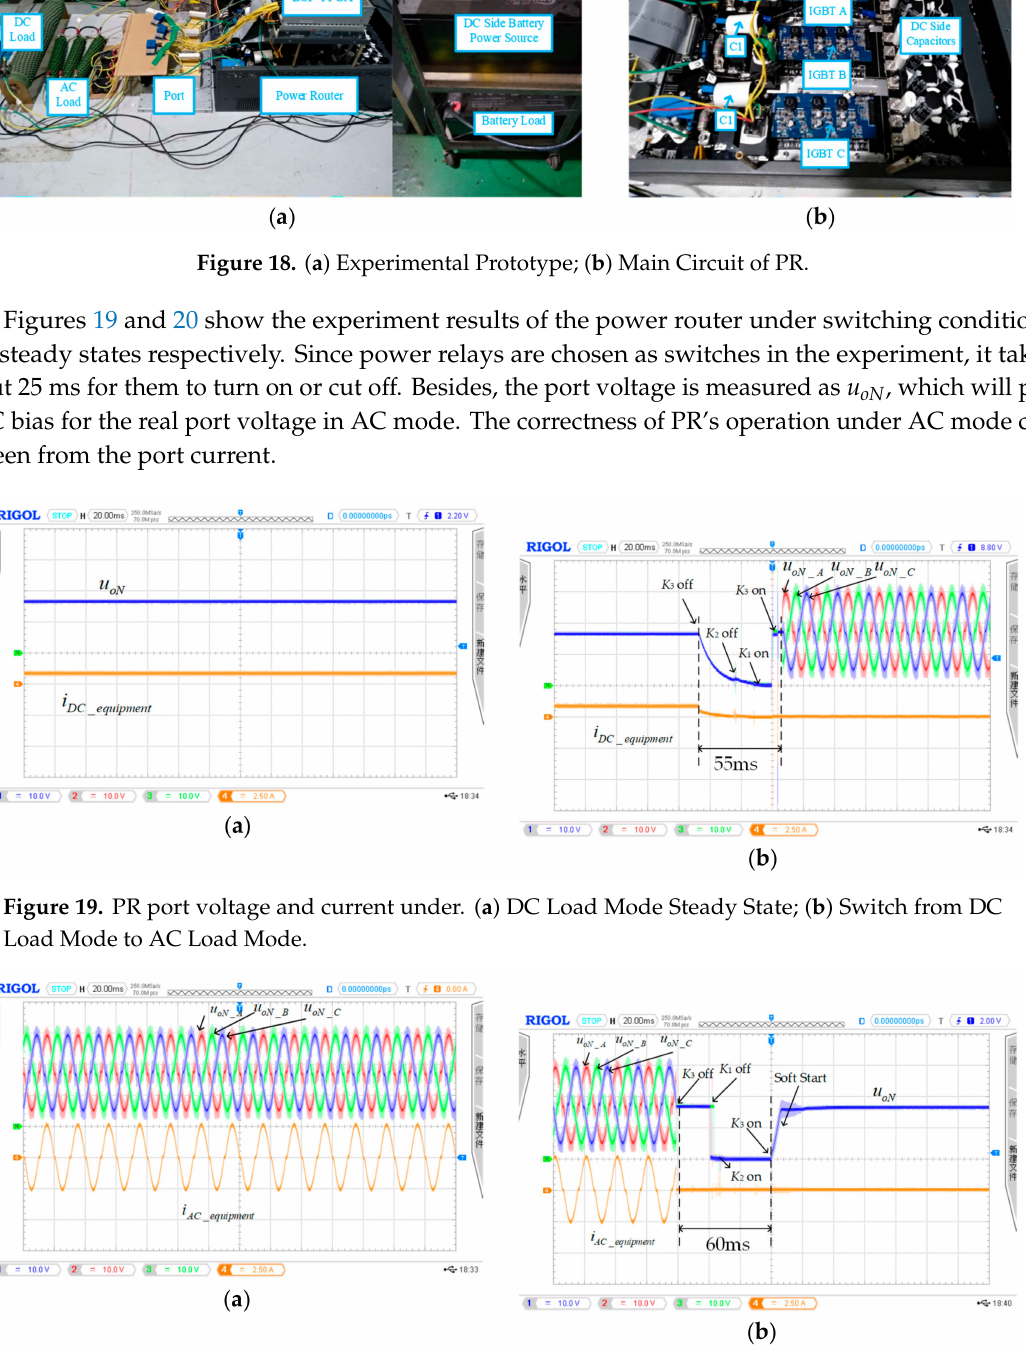
Figure 20. PR port voltage and current under. ( a ) AC Load Mode Steady State; ( b ) Switch from AC Load Mode to DC Load